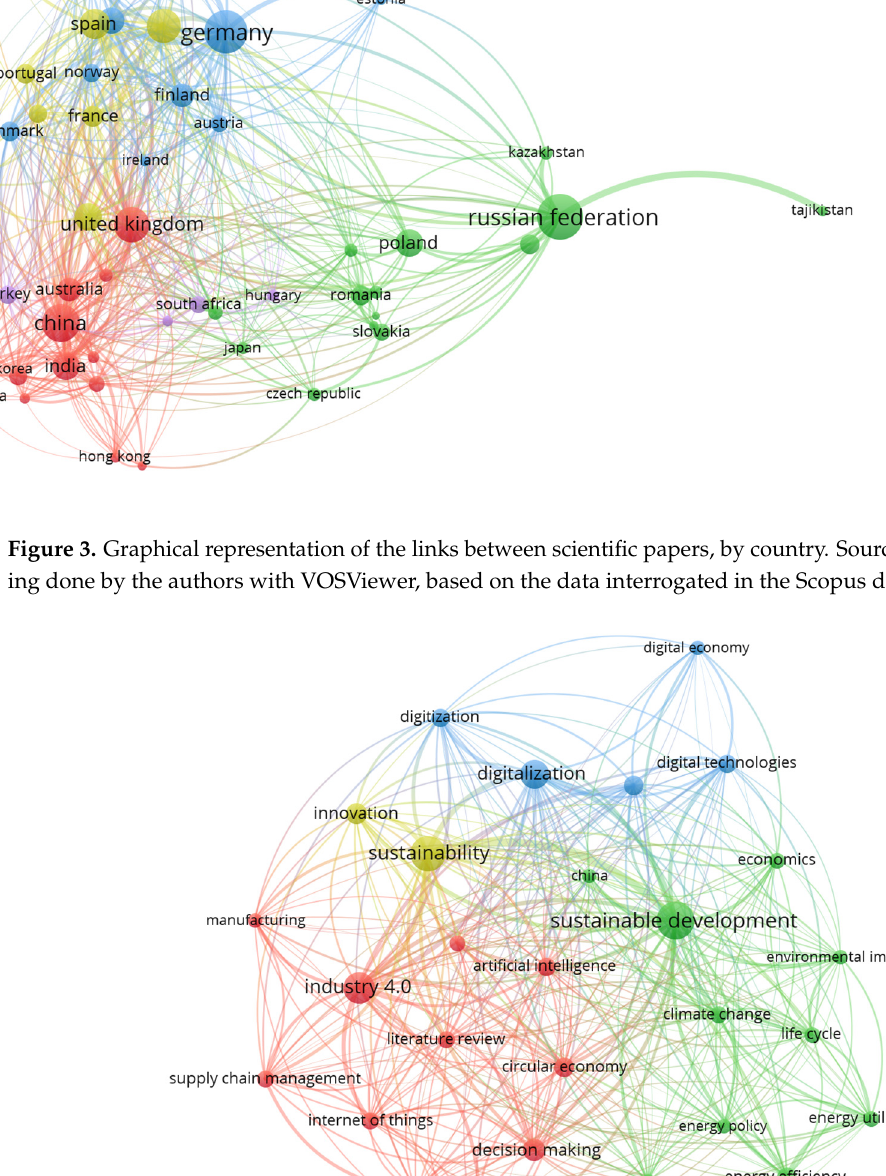
Figure 4. Graphical representation of the keywords and the links between them, relevant to the researched topic, resulted from the interrogation of the Scopus database. Source: processing done by the authors with VOSViewer, based on the data interrogated in the Scopus